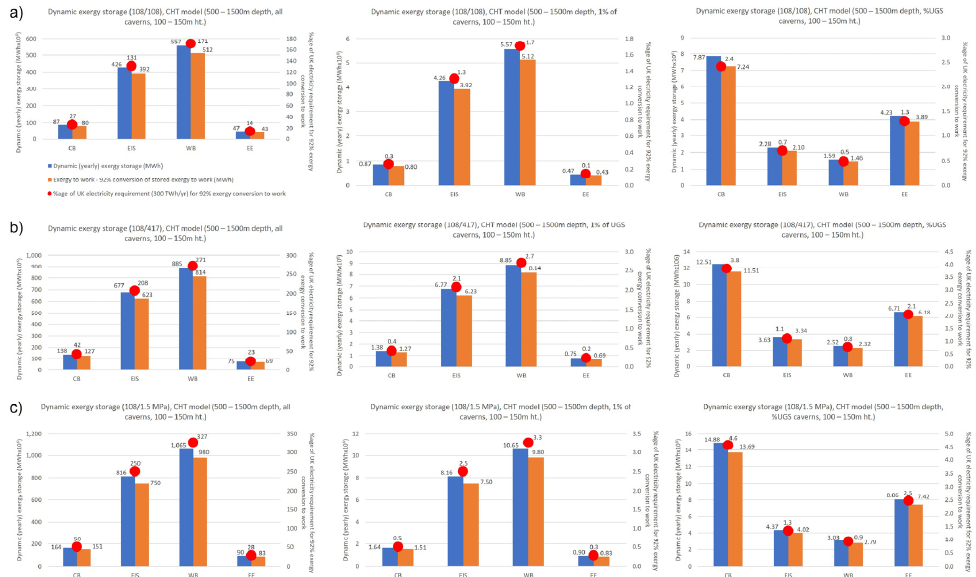
Figure 8. Plots of dynamic exergy storage and exergy to work estimates for the preferred CHT model, over the depth range 500–1500 m and cavern heights 100–150 m considered for CAES. Parts ( a – c ) show graphs for differing injection/withdrawal rates (108/108 kg/s and 108/417 kg/s) or fill and pressure reduction rates (108 kg/s/1.5 MPa/h) for all potentially available caverns, 1% of available caverns and estimates based upon the number of UGS caverns in the basins. Additionally shown, by basin, the percentage of UK electricity demand for 92% of stored exergy to work. Key common to all; see Figure 3. The authors apologize for any inconvenience caused and state that the scientific conclusions are unaffected. The original article has been